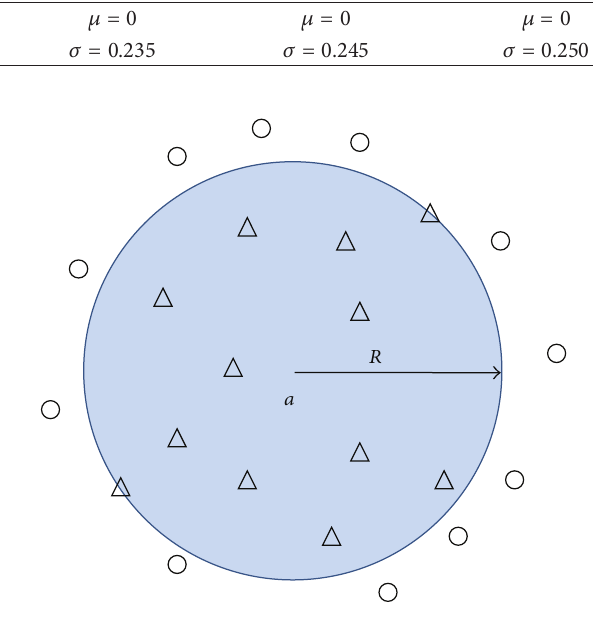
Figure 8: Sketch of